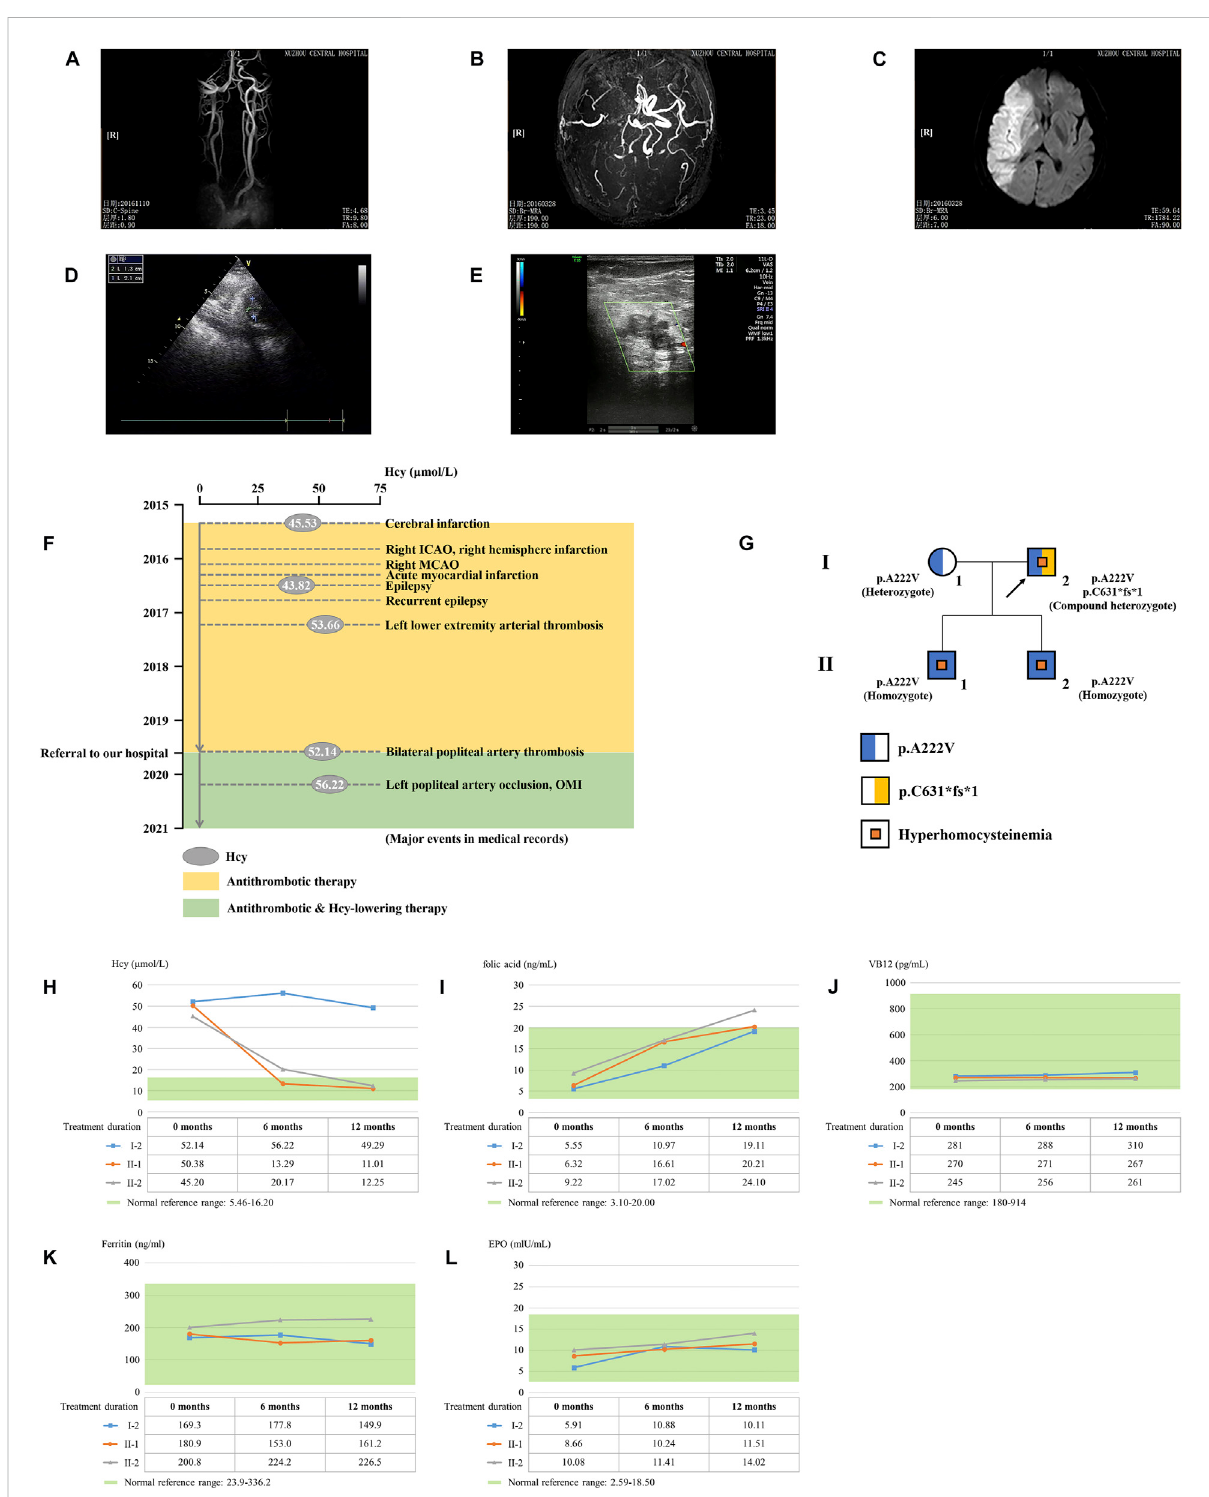
FIGURE 1 Clinical data on this HHcy family. The head MRA showed the (A) right internal carotid artery, (B) middle cerebral artery, and (C) right cerebral hemisphere of the proband (I-2). (D) Cardiac color ultrasound showed the left ventricular mural thrombosis of the proband. (E) Ultrasound examination showed lower-limb artery thrombosis of the proband. (F) Major events in the medical records of the proband. ICAO, internal carotid artery occlusion; MCAO, middle cerebral artery occlusion; OMI, old myocardial infarction. (G) Genealogy of this HHcy family. Squares indicate male family members;circles, femalemembers;and arrow, proband. (H) Time courseof Hcy-lowering therapy. The changes ofHcy, (I) folic acid, (J) VB12, (K) ferritin, and (L) EPO during